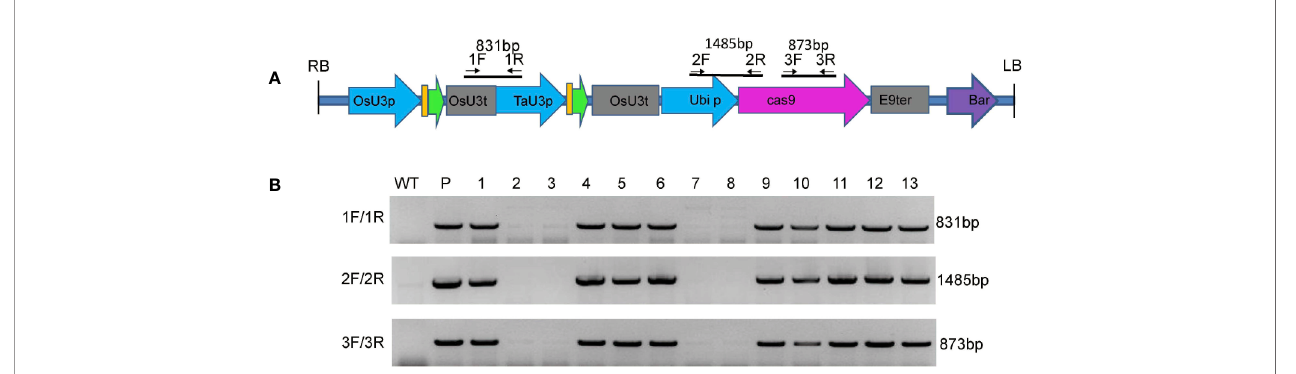
FIGURE 7 | Screening of transgene-free ga20ox3 mutants. (A) Schematic representation of the T-DNA region of the pBUE411-2gR-GA vector and the locations of the primers. (B) Agarose gel electrophoresis of three PCR fragments of T-DNA. WT, DNA of wild-type plants; P, plasmid pBUE411-2Gr; 1 – 13, individual T 2